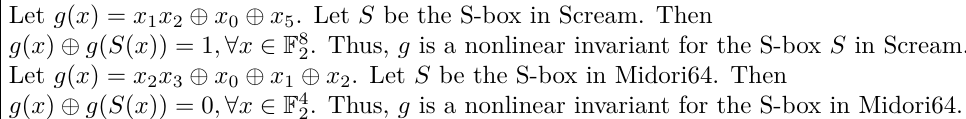
Figure 7: Examples of nonlinear invariants. Nonlinear invariant g ( x ) of the S-box is g ( x ) ⊕ g ( S ( x )) = c , where g is a non-linear Boolean function, and c is a constant.